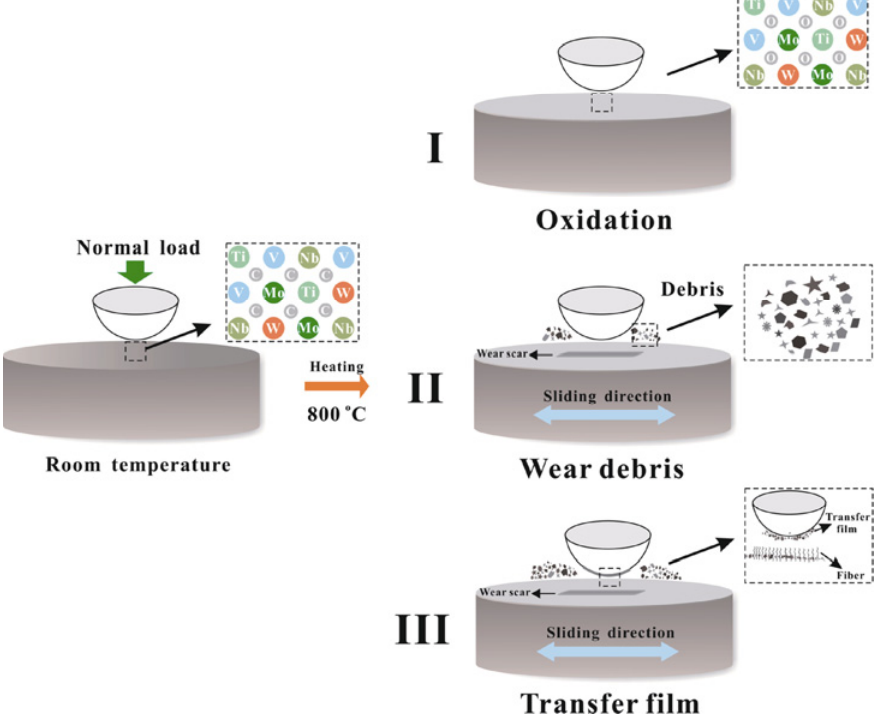
Fig. 17 Friction schematic diagram of high-entropy (TiVNbMoW)C 4.375 at 800 ℃